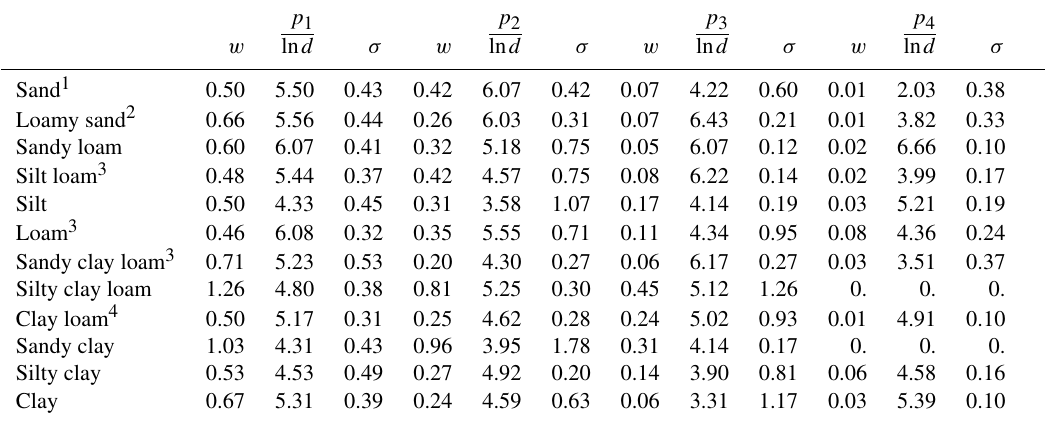
Table 3. Coefficients for minimally dispersed particle-size distributions as assigned to the 12 USGS soil texture classes. Each particle-size distribution (PSD) is composed of four lognormal distributions ( p 1 , p 2 , p 3 , and p 4 ). Coefficients are taken from Klose (2014), Table 3 (and references therein), unless otherwise indicated.